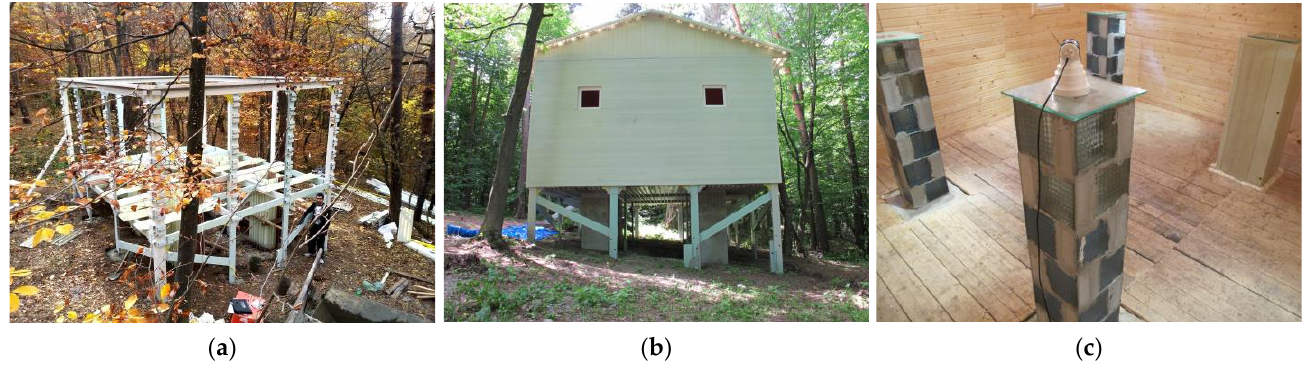
Figure 4. Absolute pavilion of the Gyulagarak observatory: ( a ) Construction process (the pavilion frame is seen); ( b ) The built pavilion; ( c ) Pavilion interior.